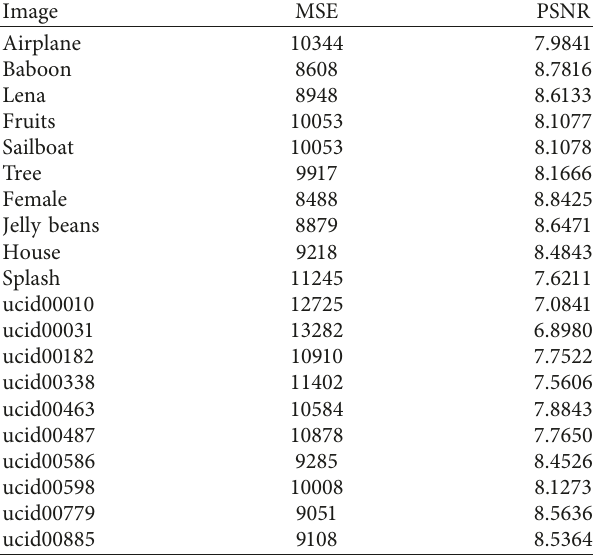
Table 3: PSNR and MSE test